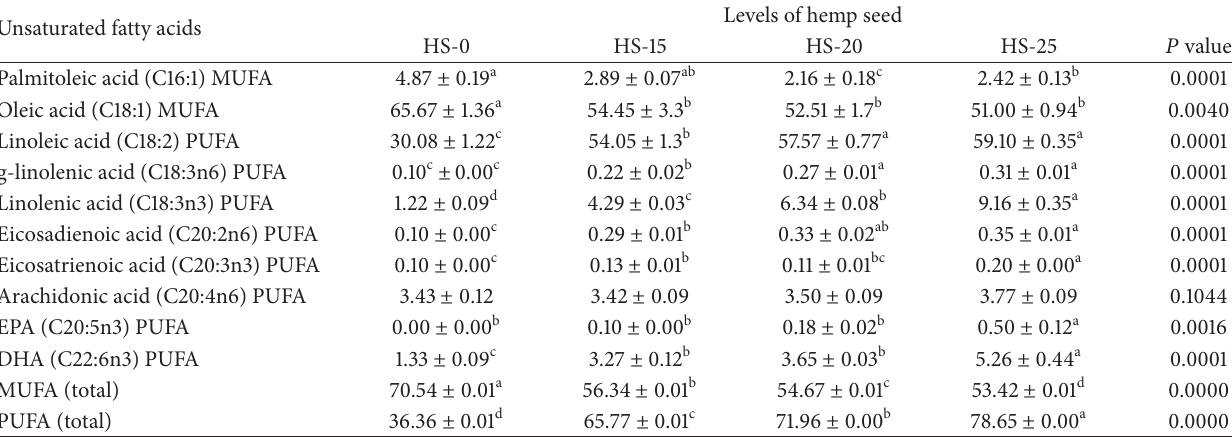
Table 4: Mean ± SE of unsaturated fatty acid (mg/g) in eggs from hens fed with different levels of hemp seed ( 𝑛 = 3 ). Unsaturated fatty acids